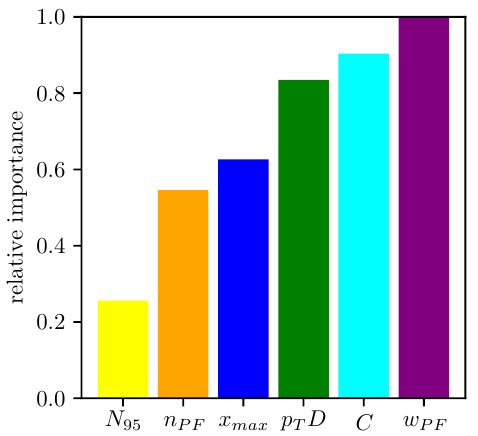
Figure 3: Feature importance of each variable in the BDT, after a D ELPHES simulation, normalized to the most important